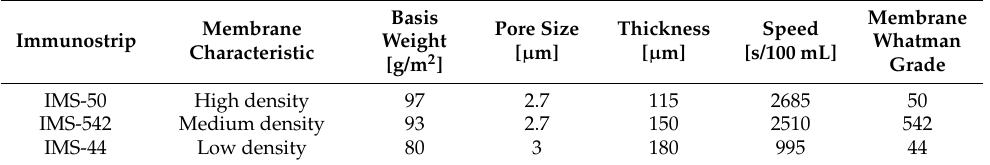
Table 2. Specifications of selected cellulose Whatman membranes used in the design of paper immunostrips. All membranes were derived from high quality cotton